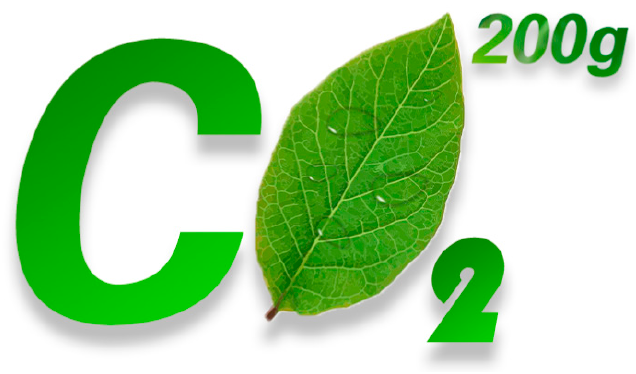
Figure 3. The self-designed carbon label.